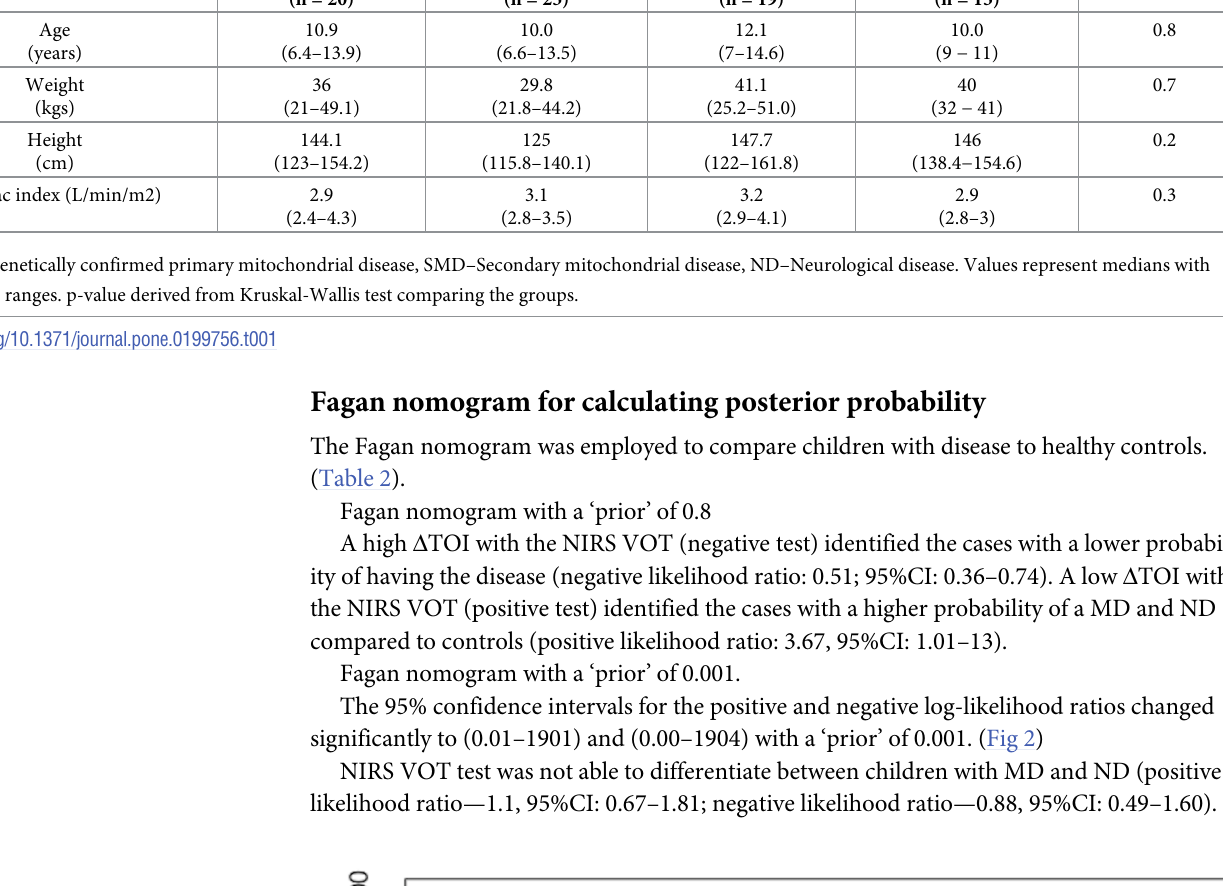
Table 1. Characteristics of children with disease and controls. Characteristic